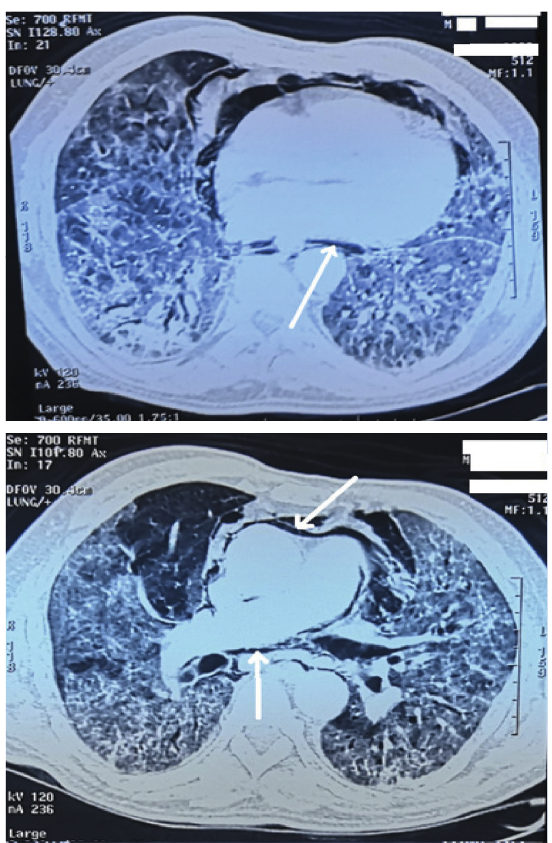
Figure 2: Chest CT scan in the axial section of the pulmonary parenchymal window showing a low-to-medium abundant pneumomediastinum (arrow) dissecting the large mediastinal vessels in a 65-year-old patient with COVID-19